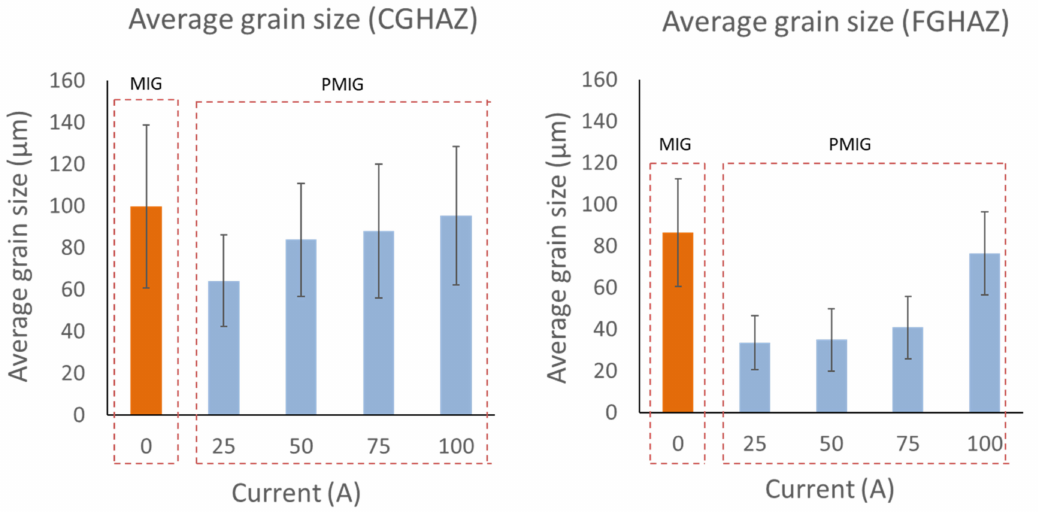
Figure 6. Average grain size ( µ m) versus current for different plasma currents in plasma MIG welding at CGHAZ and